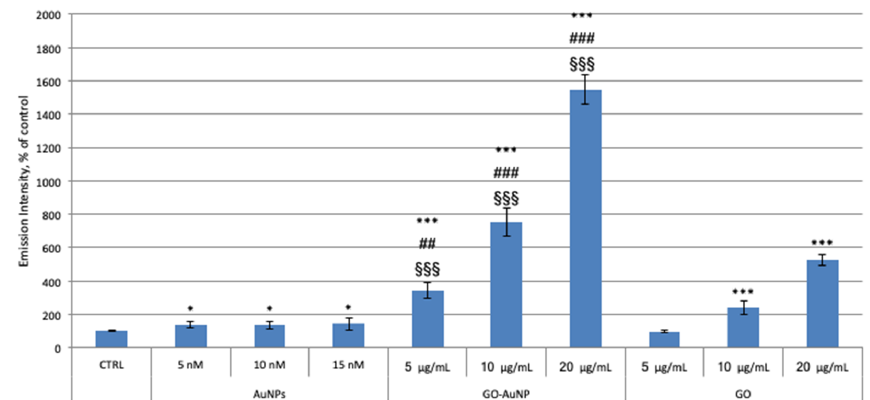
Figure 7. The 2 ′ ,7 ′ -dichlorofluorescein ( DCF) experiment on neuroblastoma SH-SY5Y cell line. Cells were incubated for 24 with AuNPs, GO-AuNP, and free GO nanosheets, at different concentrations: 5, 10, 15 nM of AuNPs; 5, 10, 20 µ g/mL of GO into the hybrids; 5, 10, 20 µ g/mL of GO alone. Results are presented as mean ± SEM from experiments in triplicate and normalized with respect to the control untreated cells. Asterisk (*) represents the correlation significant at the p ≤ 0.05 and (***) at the p ≤ 0.001 level with respect to the control; ( ## ) represents the correlation significant at the p ≤ 0.01 and ( ### ) at the p ≤ 0.001 level with respect to the AuNPs; ( §§§ ) represents the correlation significant at the p ≤ 0.001 level with respect to the GO.